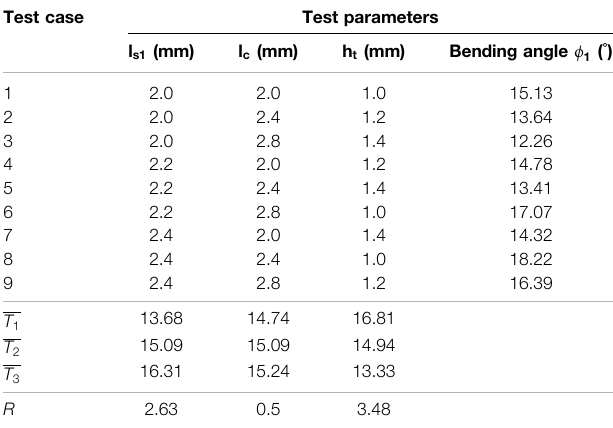
TABLE 2 | Orthogonal experiment of structural parameters in a pneumatic